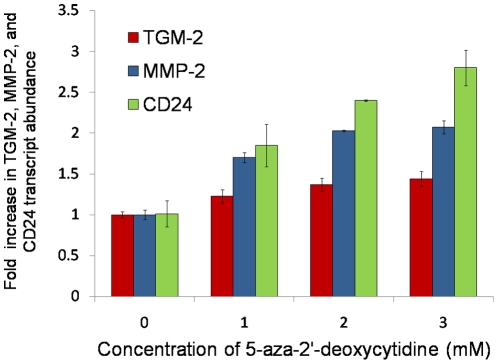
The effect of 5-aza-2′-deoxycytidine (5-aza-dC) on transglutaminase 2 (TGM-2), matrix metalloproteinase 2 (MMP-2) and CD24 transcript levels in human conjunctival epithelial cells.Cultured conjunctival epithelial cells (IOBA-NHC) were treated with 1, 2 or 3 mM of 5-aza-dC.